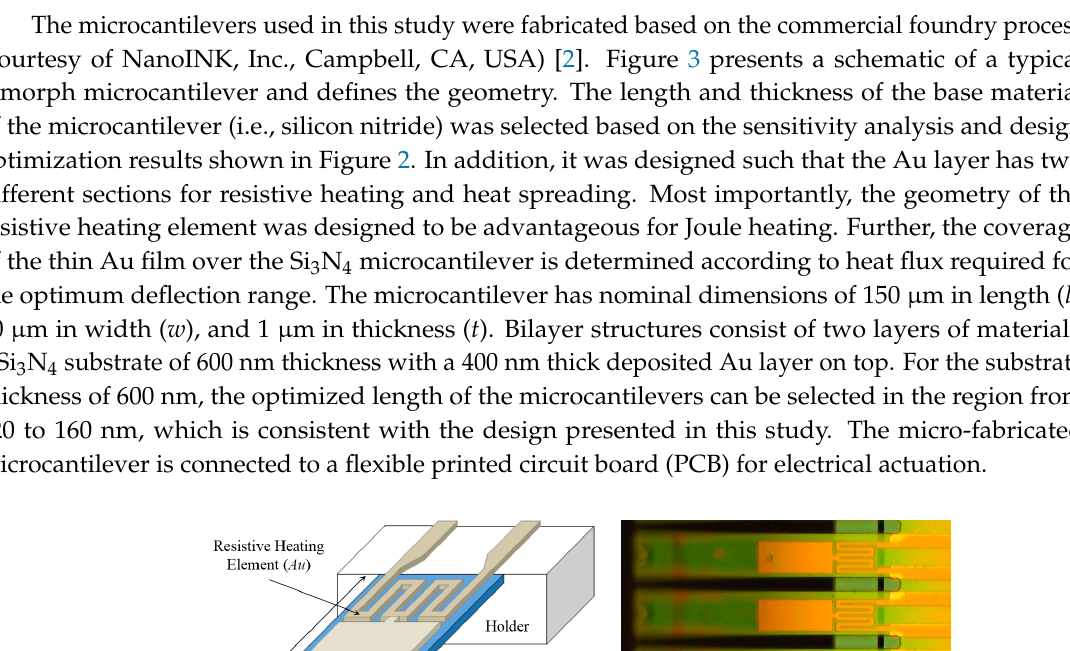
Figure 3. The bimetallic microcantilever used in this study: ( a ) A Schematic design; ( b ) Optical image of fabricated microcantilevers.